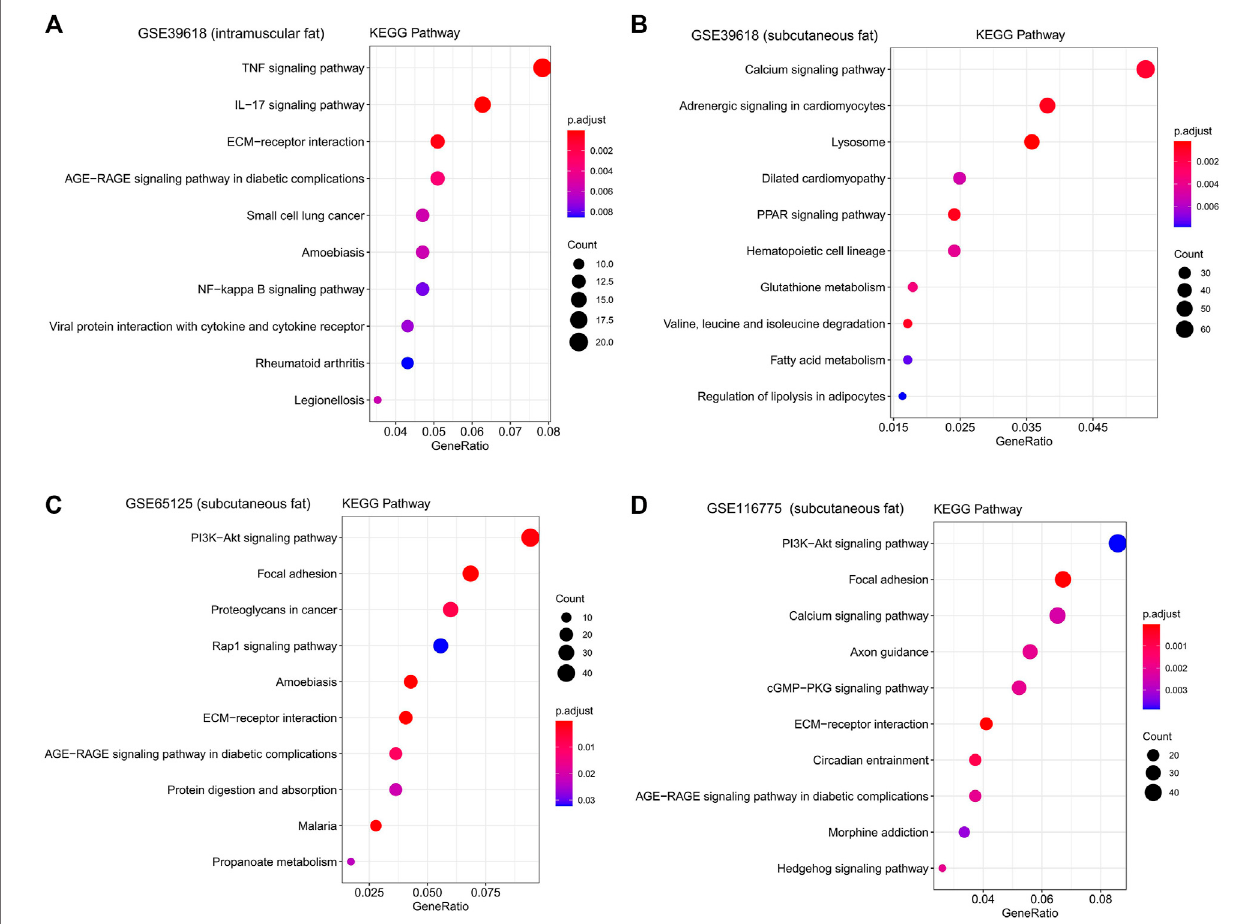
FIGURE 5| KEGG functionalenrichment analysis ofinterested modules. KEGG analysis ofgenes signi fi cantly related tointramuscular fat in the brown module (A) , inter-ribs subcutaneous fat in the turquoise module (B) , abdominal subcutaneous fat in the yellow module (C) and dorsal subcutaneous fat in the blue module (D) .